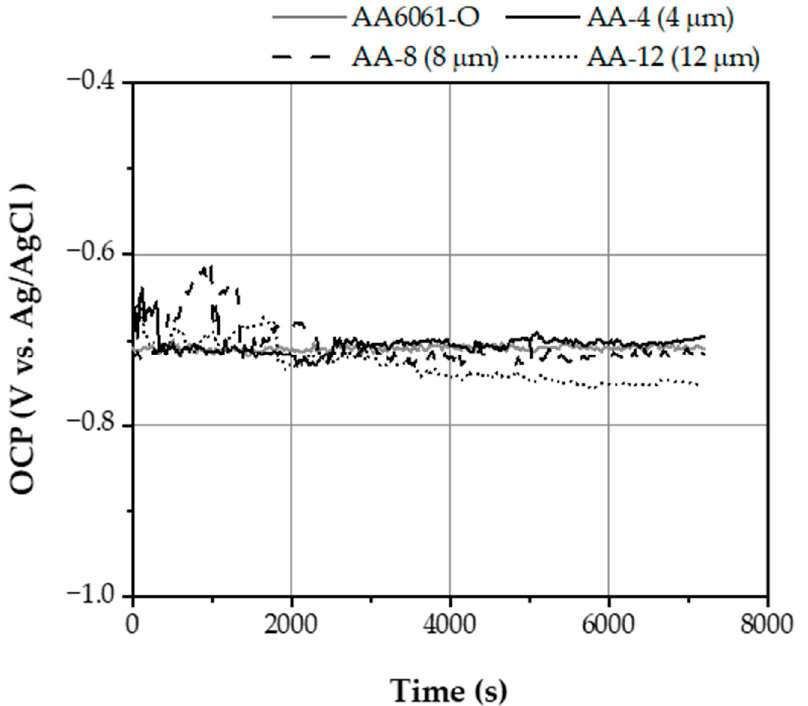
Figure 2. Evolution of the open circuit potential for the investigated samples as a function of immersion time in corrosive media.